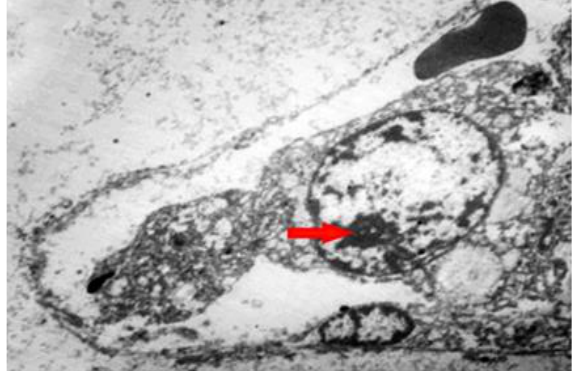
Fig. 5. Electron microscopy showed the presence of nucleolus in the nucleus of neutrophil; (Original magnification ×5,000). (Courtesy of Mr. Majid Asadi PhD, Kerman